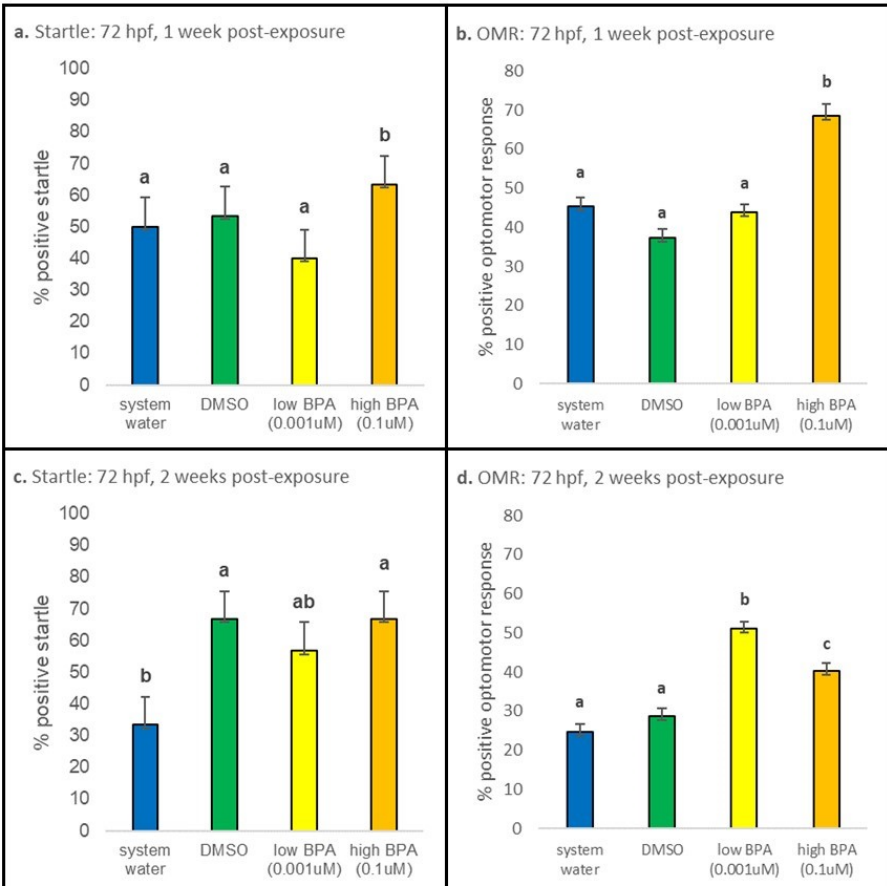
Figure 6. Seventy-two hours postfertilization behavioral results. ( a ) After 1 week of recovery, larvae exposed to the high concentration of BPA at 72 hpf displayed statistically increased startle responses relative to all other treatment groups ( p < 0.001). ( b ) There was also a significant increase in positive OMRs ( p < 0.001) in the high BPA group. ( c ) At the 2 week recovery time, larvae exposed to high BPA displayed significantly increased startle responses compared to low BPA exposed larvae ( p = 0.003), though neither response was different from the vehicle control. ( d ) The percentage of larvae displaying a positive OMR was significantly increased in both the low BPA ( p < 0.001) and high BPA ( p = 0.001) treatment groups, with the greatest response observed in larvae exposed to low BPA. At each recovery point n = 30 for all treatment groups. Startle responses were analyzed using a one-way ANOVA performed separately for each age and treatment group; if significance was noted, a Tukey post hoc test was performed to identify differences. OMR was analyzed using a one-way ANOVA, followed by a post hoc multiple comparison (with a Bonferroni correction). All values are reported as mean ± SE. Different letters denote significance.